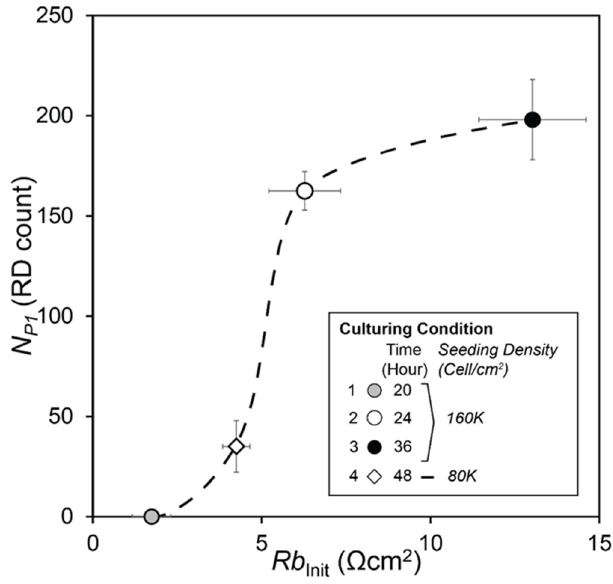
Figure 12. N P 1 vs. Rb Init . The Phase 1 length, N P1 , has strong correlation with Rb Ini t , with p <<